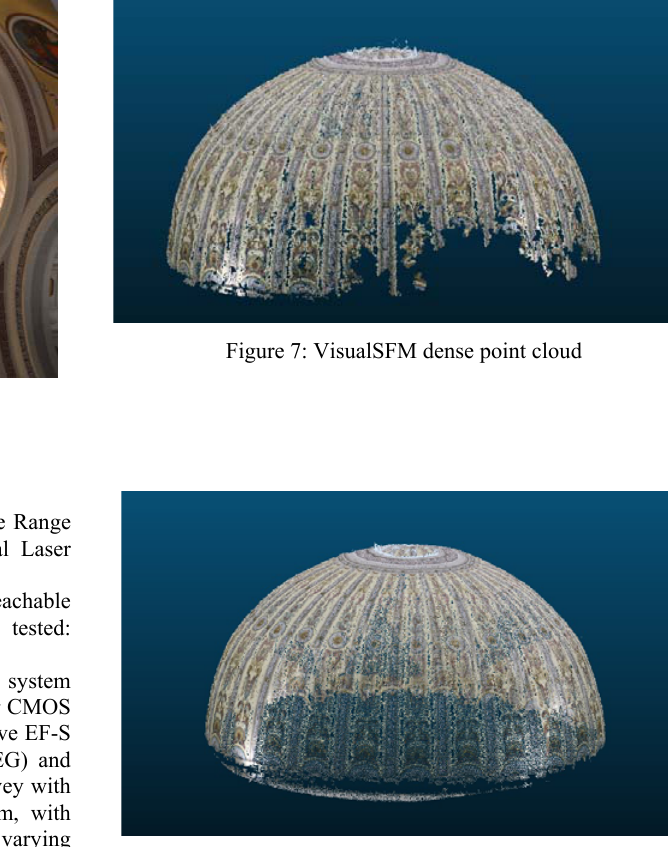
Figure 8: Regard 3D dense point cloud